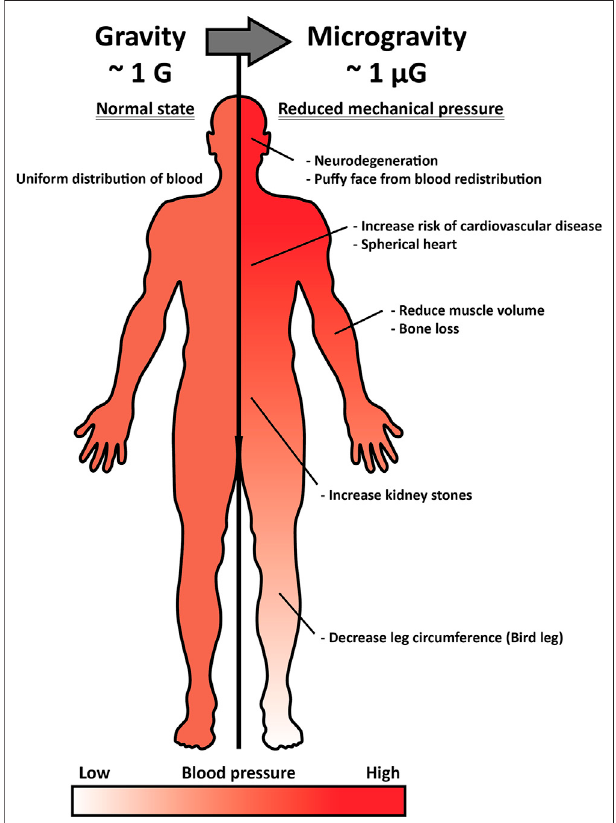
FIGURE 1 | Inner pressure change by interstitial fl uid shift under microgravity and its effect on the human body. Under normal gravitational force ( ∼ 1G), the pressure of interstitial fl uid maintains a head-to-foot hydrostatic gradient (left). Under microgravity ( ∼ 1 µG), the interstitial fl uid and pressure shifts upward, and such alteration induces optic disc stress, spherical heart, puffy face, kidney stone formation, bird leg, and muscle atrophy